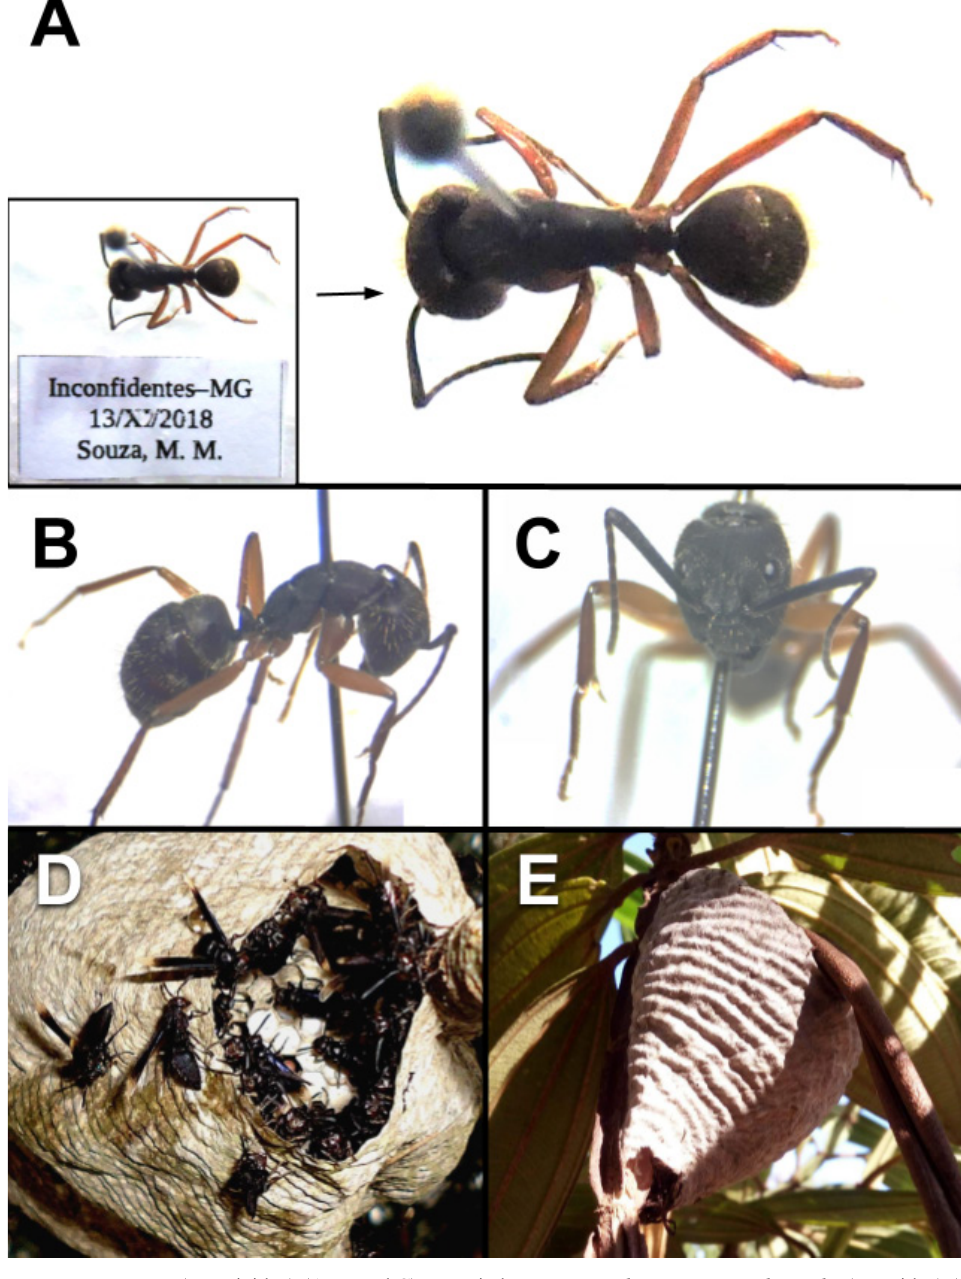
Fig 1 . Camponotus renggeri (Formicidae) (A, B and C) occupied a nest Parachartergus pseudapicalis (Vespidae) (D and